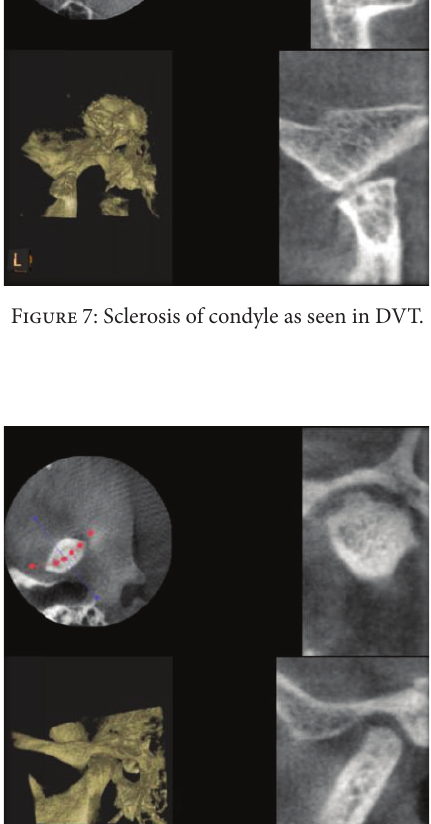
Figure 11: Bifid condyle as seen in